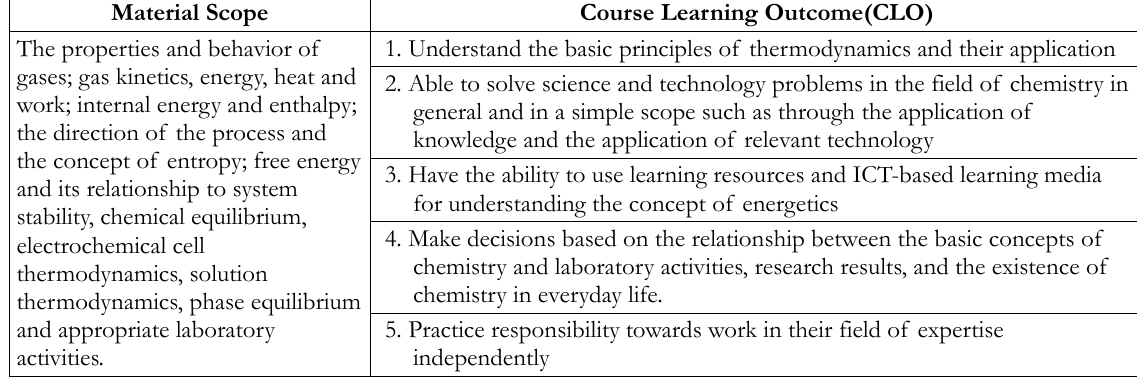
Table 1. The matrix of chemical thermodynamics course